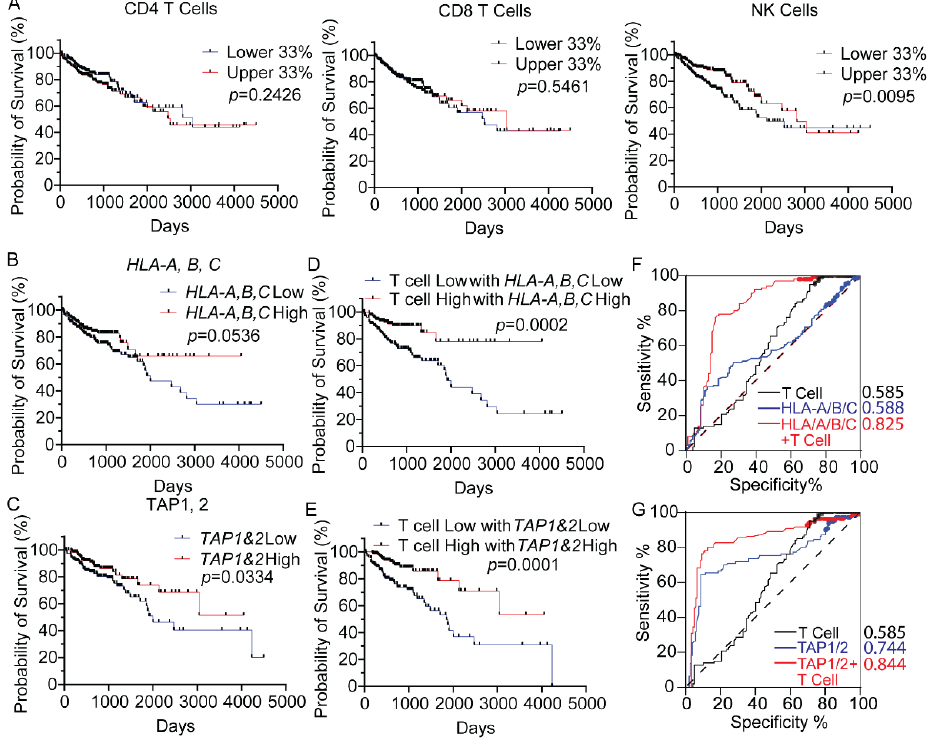
Figure 1. Expression of MHC-I molecules is associated with patient prognosis in CRC . ( A ) Kaplan – Meier curves showing the survival probability of 459 TCGA CRC patients based on the tumor infiltrating CD4 T cell, CD8 T cell, and NK cell levels. Survival data are from samples with higher (upper 33%) and lower (lower 33%) immune cell fraction. ( B ) Kaplan – Meier curves showing the survival probability of CRC patients based on HLA-A , B , C expression levels. ( C ) Kaplan – Meier curves showing the survival probability of CRC patients based on HLA-A , B , C expression levels and T cell levels. ( D ) Kaplan – Meier curves showing the survival probability of CRC patients based on TAP1 , 2 expression levels. ( E ) Kaplan – Meier curves showing the survival probability of CRC patients based on TAP1 , 2 expression levels in patients with low T cell levels. ( F , G ) Receiver oper- ating characteristic (ROC) curve and area under curve (AUC) values for the prognostic prediction model based on T cell infiltration and MHC-I expression. We then further analyzed the prognostic effect of MHC-I molecules on CRC patients. As shown in Figure 1B, the expression level of HLA-A/B/C does not statistically signifi- cantly affect the survival rate of CRC patients ( p = 0.0536, nearly statistically significant, suggesting the MHC-I molecules may somewhat influence survival). However, if the col- orectal tumors have both HLA-A/B/C expression high and T (CD4+ T and CD8+ T) cell infiltration high, the patients have a significantly better prognosis ( p = 0.0002) (Figure 1D). Higher expression of TAP1 and TAP2 , another two molecules essential for MHC-I-medi- ated antigen presentation, is significantly correlated with better prognosis, and it is also the case when coupled with T cell expression (Figure 1E). Receiver operating characteristic (ROC) curve and area under curve (AUC) values showed that the combination of MHC-I molecules and T cell infiltration have a better predictive performance than MHC-I or T cell infiltration alone (Figure 1F, 1G). These results further indicate that the expression of MHC-I is required for T cell surveillance in CRC. 3.2. DDX60 and ISG15 Are Potential Candidates Correlated with MHC-I Expression The comparison of the expression level of MHC-I molecules in the tumors from im- munotherapy responders and non-responders suggests that MHC-I expression might be downregulated in CRC cells from non-responders (Figure S1). We then tried to screen out